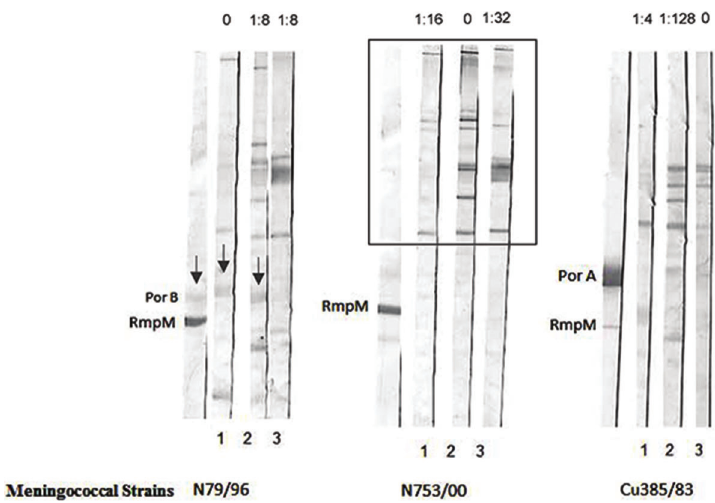
Figure 1. Immunoblot reaction with outer membrane vesicles from meningococcus serogroup C strains N79/96 and N753/00, and meningococcus sero- group B strain Cu385/83. Strips 1, 2 and 3 represent serum samples from carriers. Serum bactericidal antibody titer is shown on the top of each strip (log 2 ). Monoclonal antibodies against PorB (F1-9H10/ 1B3, weak reaction), PorA (F8-7A2/1H11) and RmpM (BE12) were used as control markers and as positive controls in the fi rst